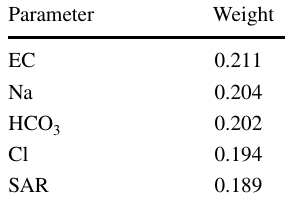
Table 6 The used parameters and weights (Meireles et al. 2010)